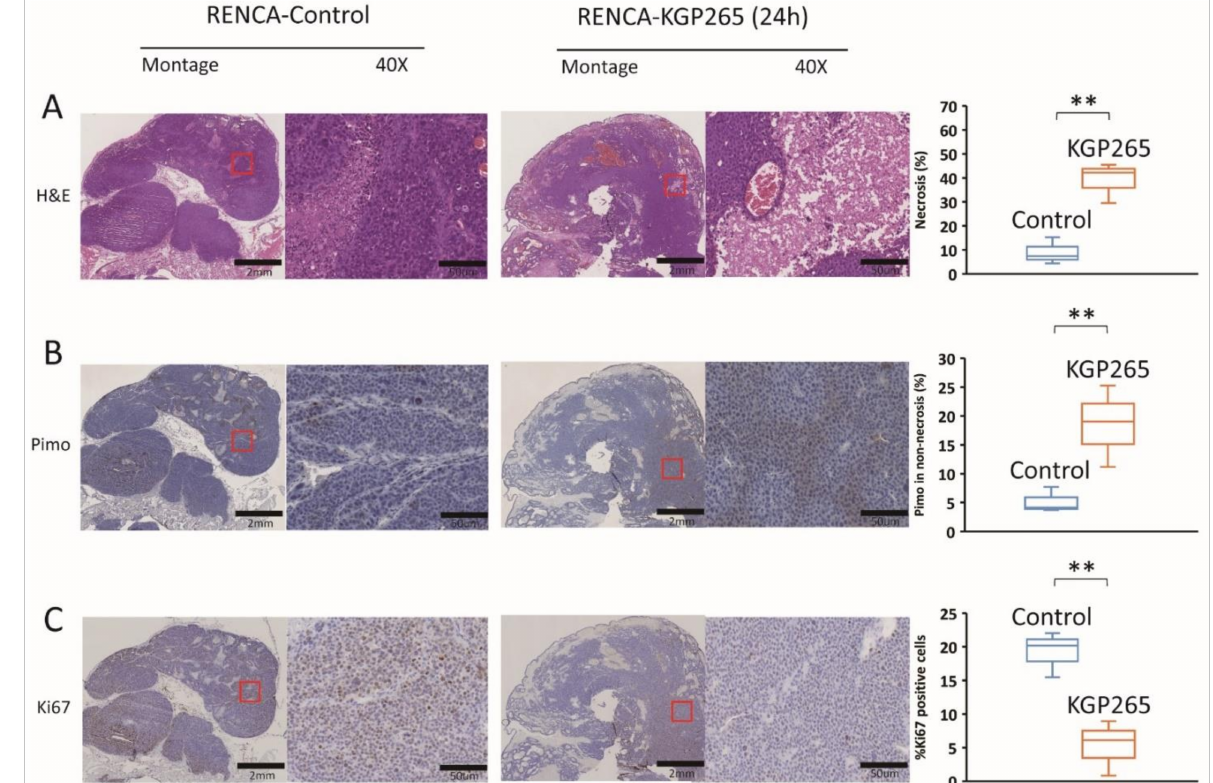
Figure 8. Histological analysis of IHC staining of RENCA tumors in response to KGP265. ( A ) H&E staining shows differences between the control and KGP265-treated RENCA tumor tissues. ( B ) IHC images of RENCA tumor tissue sections, and graphs showing the levels of pimonidazole in the control and KGP265-treated tumors. ( C ) Representative IHC images of RENCA tumor tissue sections, and graphs showing the levels of Ki67 in the control and KGP265-treated tumors. The red rectangles in the montages show the regions in 40 × magnified images. Scale bar: montage, 2 mm; 40 × , 50 µ m. The staining levels were quantified, and the data are plotted as the mean ± SEM. The values shown in the graphs are averages of the signals quantified from three independent tumors in the IHC experiments. For the statistical analysis, the levels in the treated tumors were compared to the levels in the control tumors with an unpaired t -test. ** p <